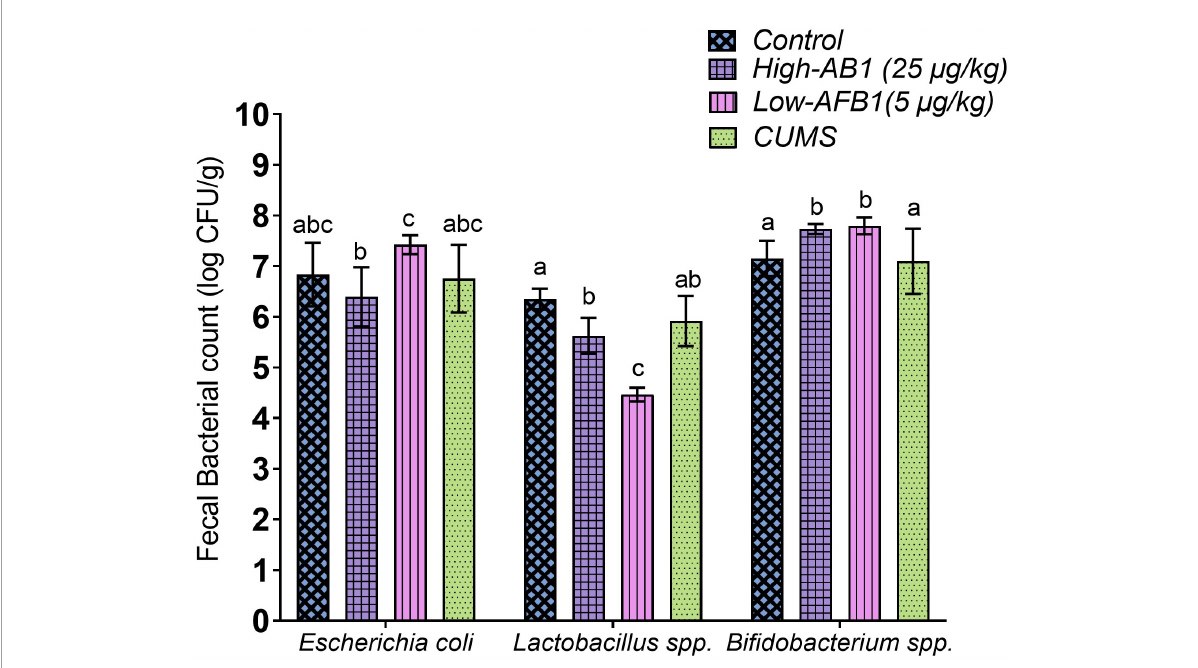
FIGURE2 Fecal bacterial count of Escherichia coli, Lactobacillus spp., and Bifidobacterium spp. Data are expressed as mean ± SD, n = 8. Means between groups within columns that do not share the same lowercase letters (a, b, c) are significantly different ( p < 0.05) using Tukey HSD post-hoc